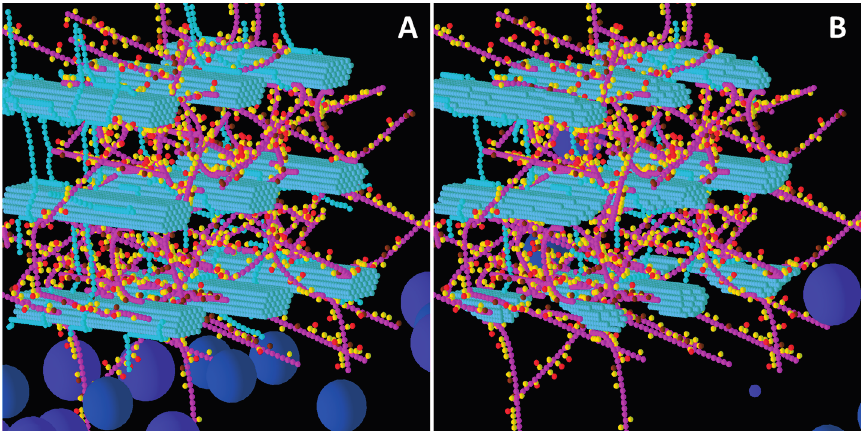
Figure 1. Initial structure of the Low glucuronoarabinoxylan (GAX) model cell wall ( A ) and the end result of its degradation after a simulation run ( B ). Glucose, xylose, arabinose, glucuronic acid and ferulic acid are represented by the smaller spheres coloured blue, magenta, yellow, brown and red respectively. Larger spheres represent Cel51A ( purple ) and Cel9D ( blue ). Enzymes shown in pane A are in their original positions, located in the hypothetical biofilm area. Some enzymes do not appear solid, because of incomplete graphics rendering due to resource limitation. The graphs are 3-D, and therefore enzymes at the far end of the simulation environment appear small due to the perspective of the graphs (e.g., pane